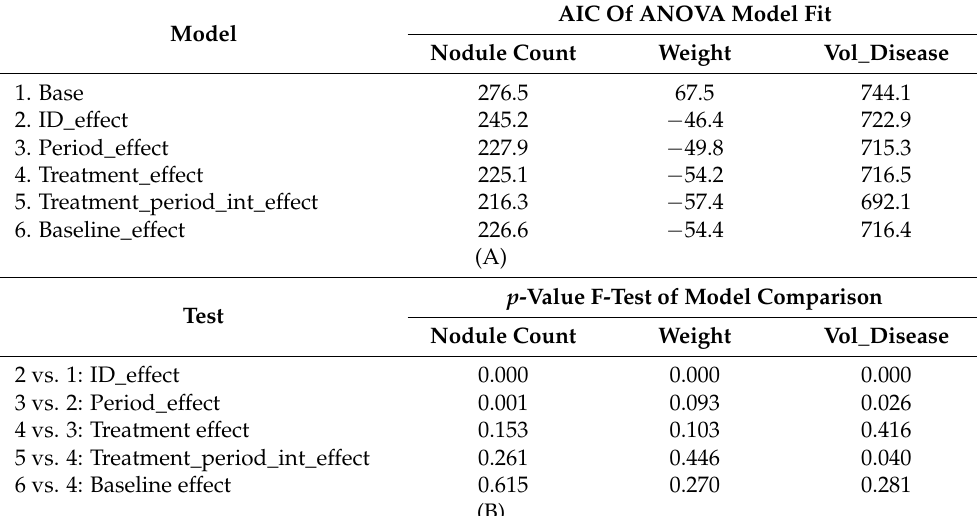
Table 2. (A)—Akaike Information criterion for ANOVA models for study 1. (B)—Likelihood ratio test of ANOVA models of Study 1